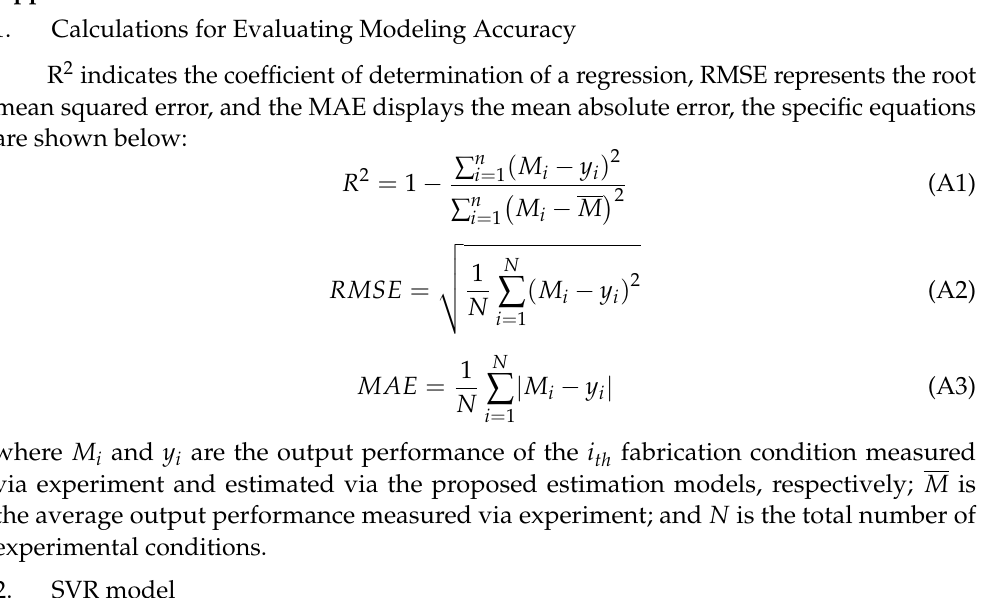
Table S2. ANOVA for the response of the sensitivity; Table S3. ANOVA for the response of the creep; Figure S1. The relationship between Ni content and performances. (a) Relationship between Ni content and creep; (b) relationship between Ni content and sensitivity; Figure S2. The relationship between MWCNT content and performances. (a) Relationship between MWCNT content and creep; (b) relationship between MWCNT content and sensitivity; Figure S3. The relationship between MLG content and performances. (a) Relationship between MLG content and creep; (b) relationship between MLG content and sensitivity; Figure S4. The relationship between magnetic field intensity and performances. (a) Relationship between magnetic field intensity and creep; (b) relationship between magnetic field intensity and